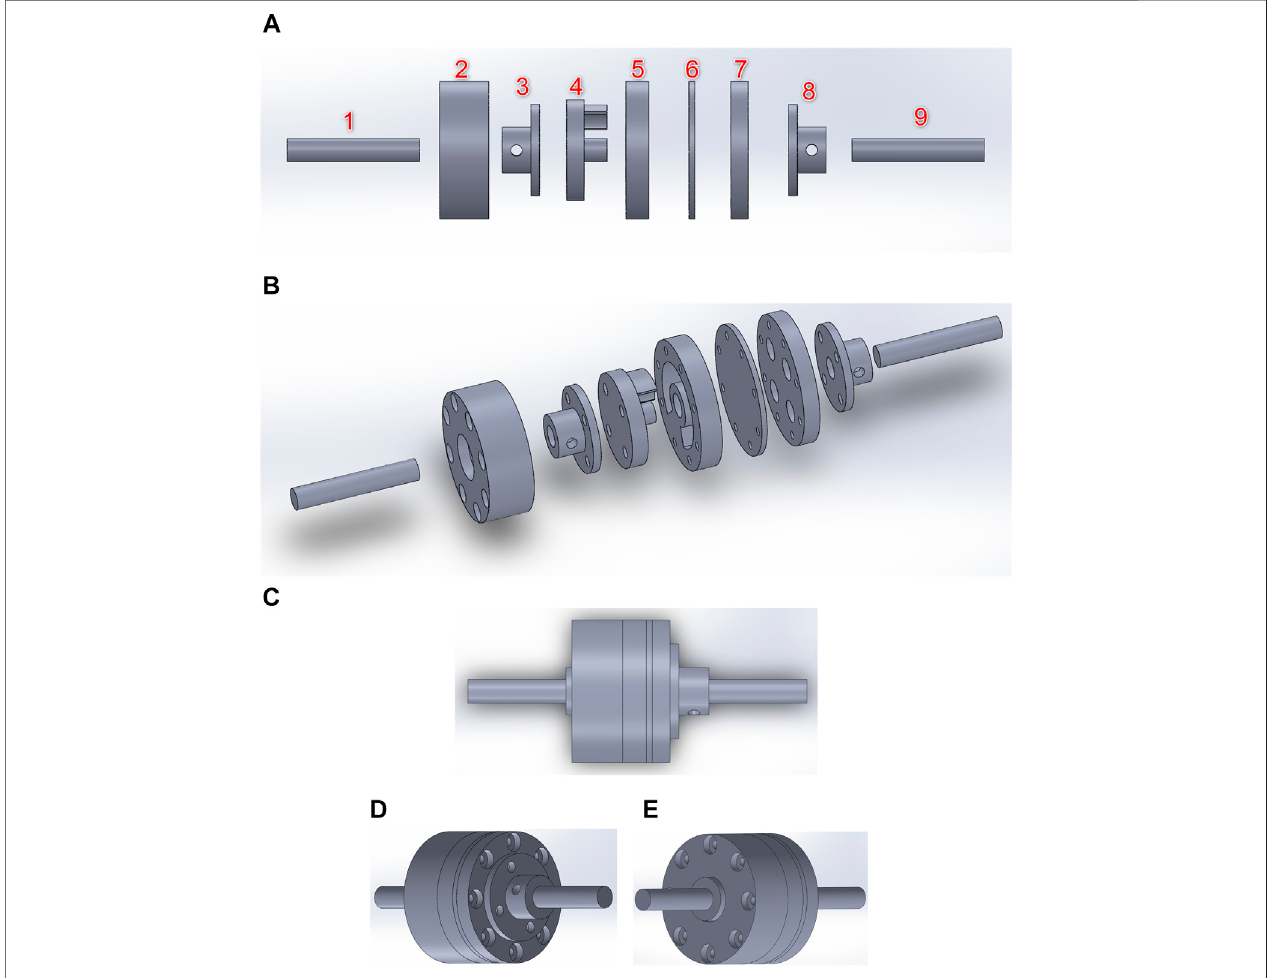
FIGURE6| Mechanicaldesignoftheelasticjoint (A) explodedview.Loadside:(1)loadsideshaft,(2)cap,(3)8 mm-shaft fl ange,(4)loadsidecompliantjoint.Motor side:(5)motorsidedrivingjoint,(6)cover,(7) fl angeextension,(8)8 mm-shaft fl ange,(9)motorsideshaft (B) 3Dviewoftheelasticjoint (C) assembledviewofthedesign of the elastic joint (D) view from the motor side (E) view from the load side.